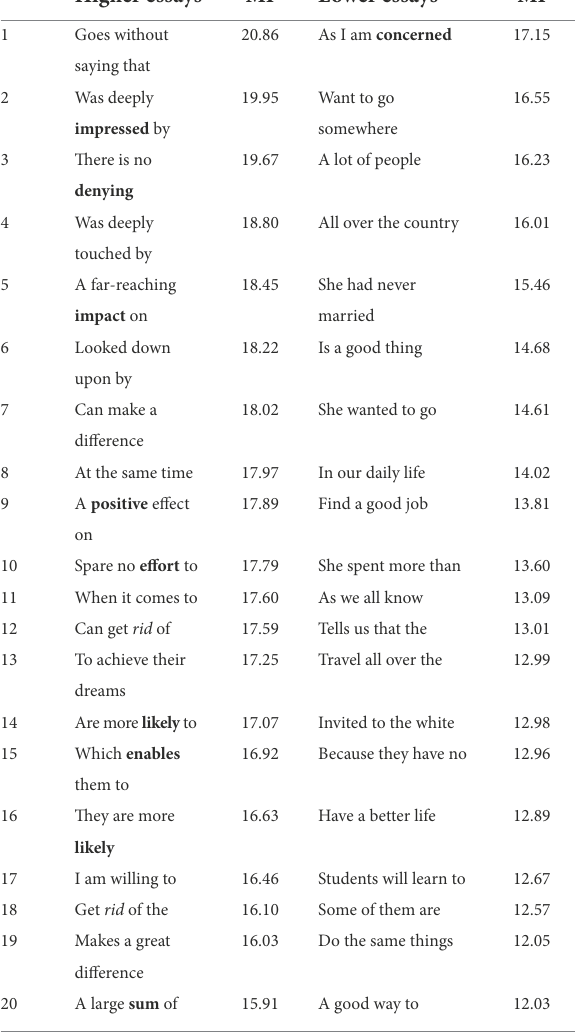
TABLE 4 4-Word sequences characterized by high MI in high- and low-rated essays. Higher essays